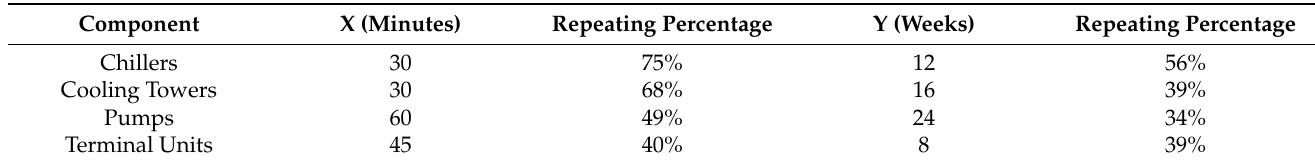
Table 8. Frequencies outcome.